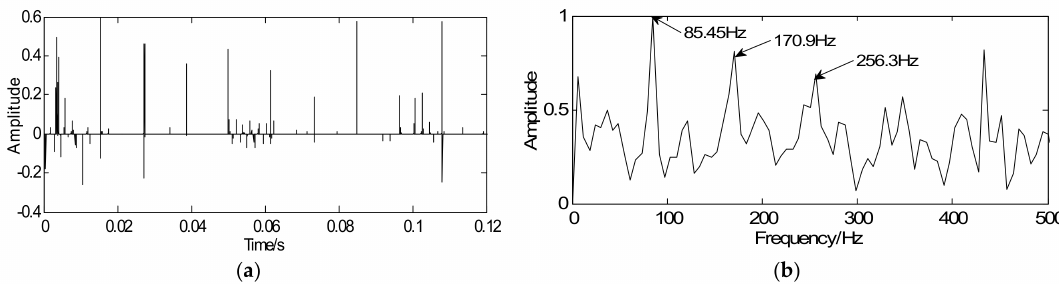
Figure 8. Detection results of outer-race fault using the proposed method: ( a) waveform of sparse signal and ( b ) envelope spectrum of the sparse signal.